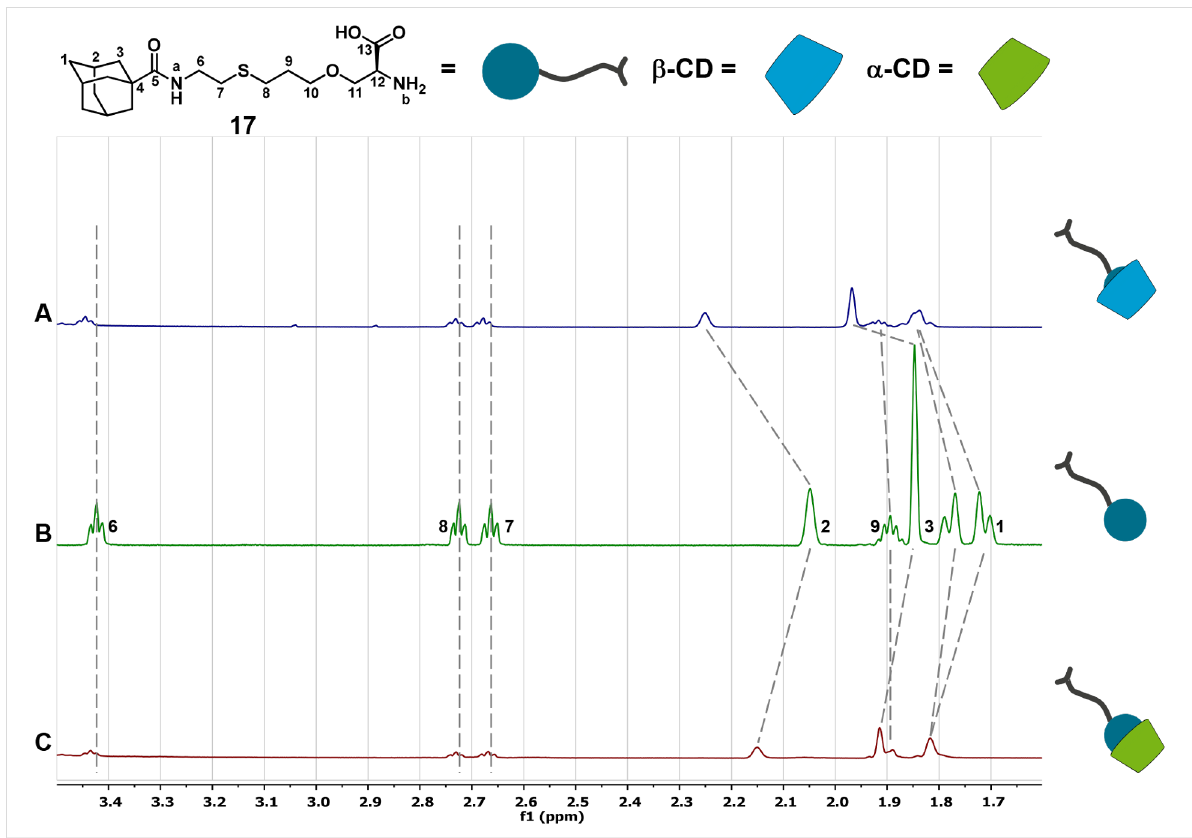
Figure 4: 1 H NMR spectra of 17 (B) and its inclusion complexes with β - (A) and α -CD (C), measured in D 2 O (600 MHz, 25 °C). A) [17] = 1.0 mM, [ β -CD] = 10 mM. B) [17] = 1.0 mM. C) [17] = 1.0 mM, [ α -CD] = 10 mM.